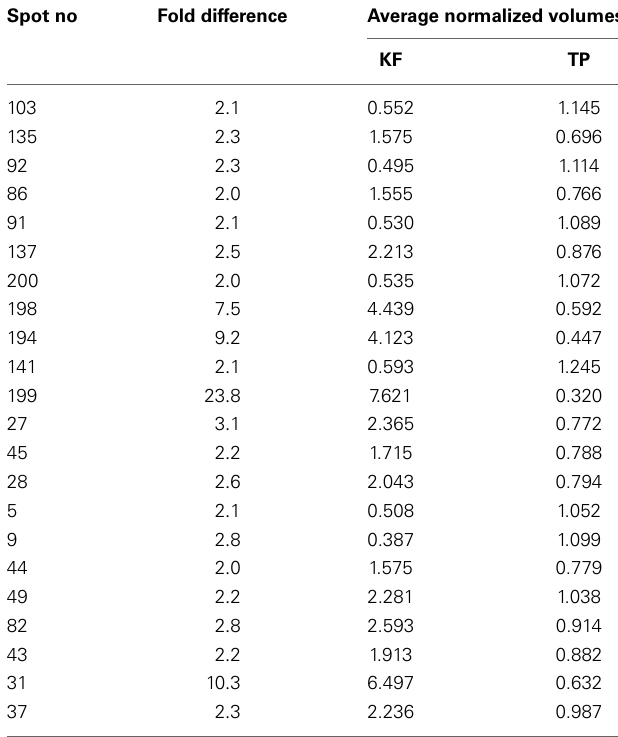
purity of the Sertoli cells was 92% and of the spermatogenic cells was